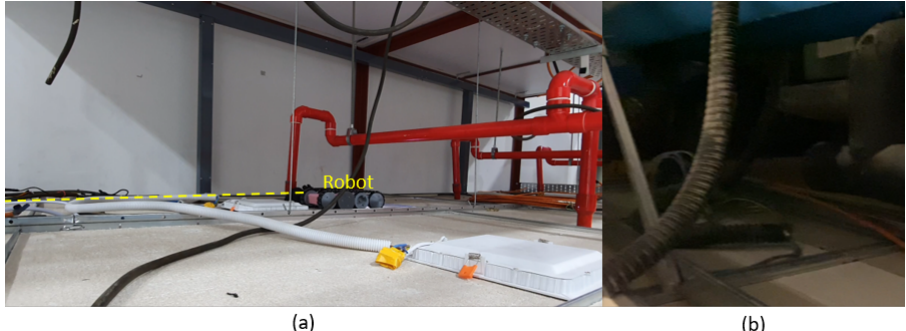
Figure 1. Robot-aided inspection process of a false ceiling. ( a ) A robot inspecting a false ceiling. The dashed line represents a path preferred by the robot for inspection. ( b ) Poor lighting condition expected in a false